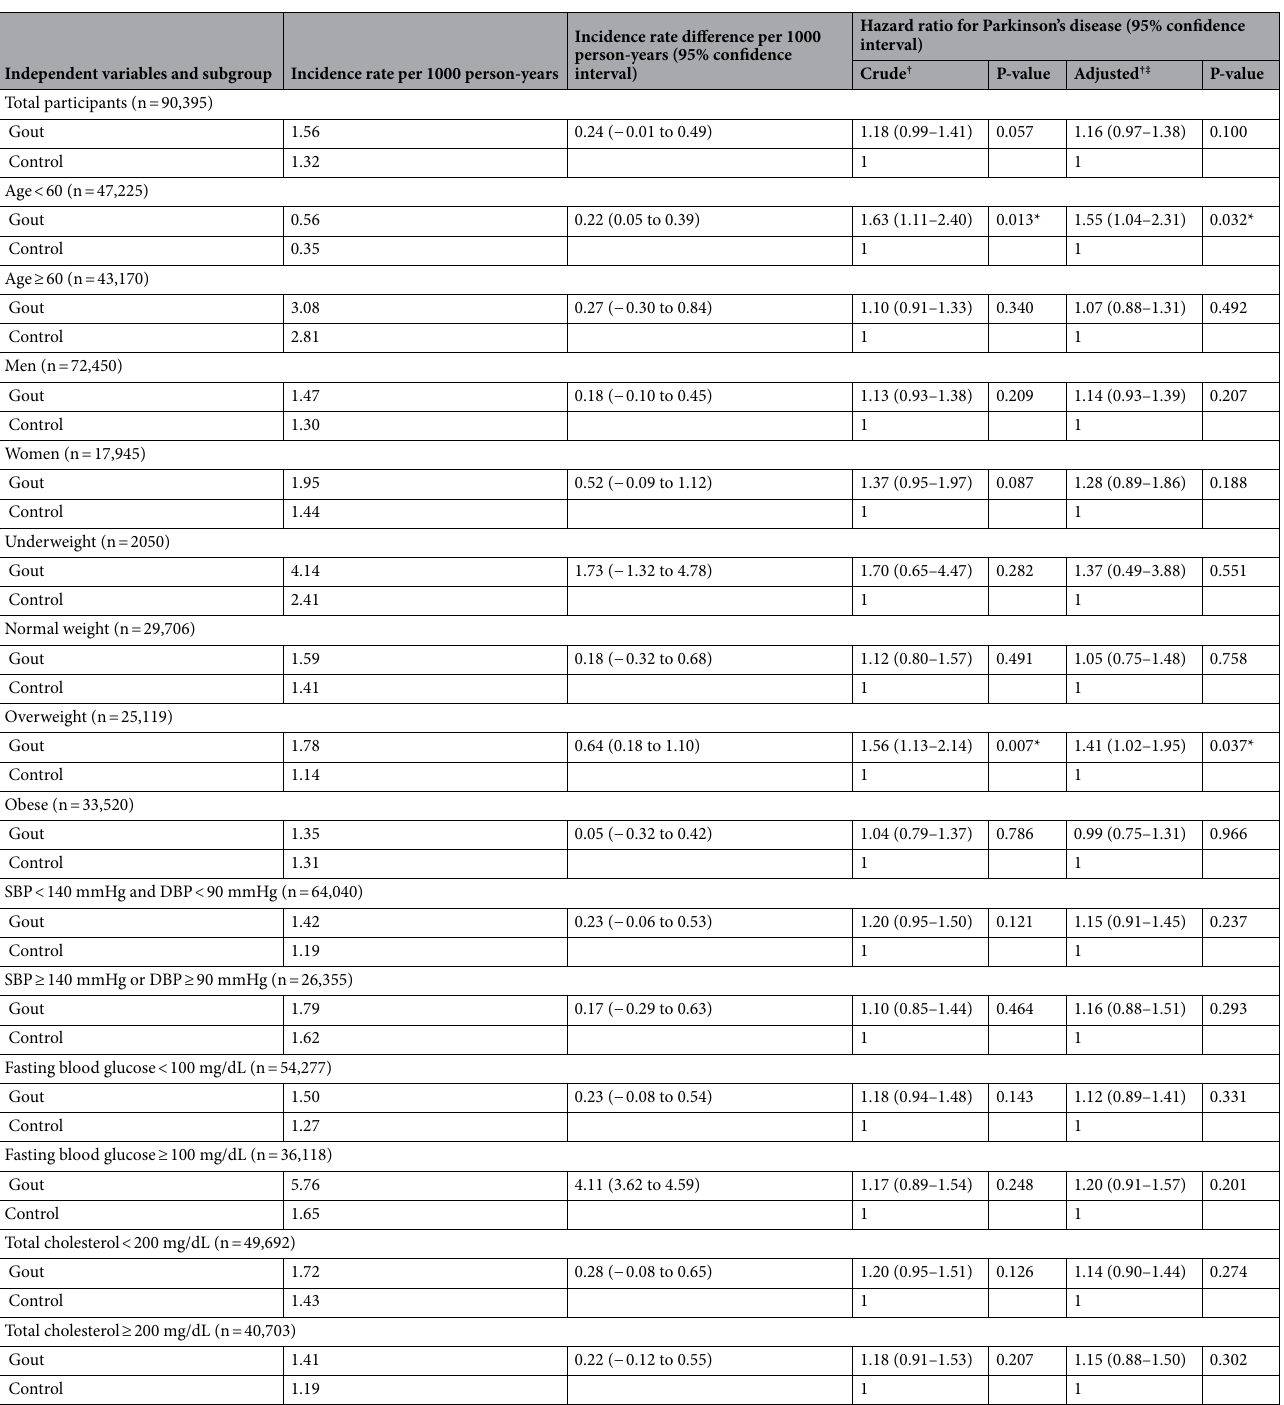
Table 3. Crude and adjusted hazard ratios of gout for Parkinson’s disease with subgroup analyses stratified based on covariates. SBP systolic blood pressure, DBP diastolic blood pressure. *Stratified or unstratified cox proportional hazard regression model, Significance at P < 0.05. † Matched model based one age, sex, income, and residential area. ‡ Adjusted for obesity, smoking status, alcohol consumption, SBP, DBP, fasting blood glucose, total cholesterol, Charlson comorbidity index scores, and Alzheimer’s